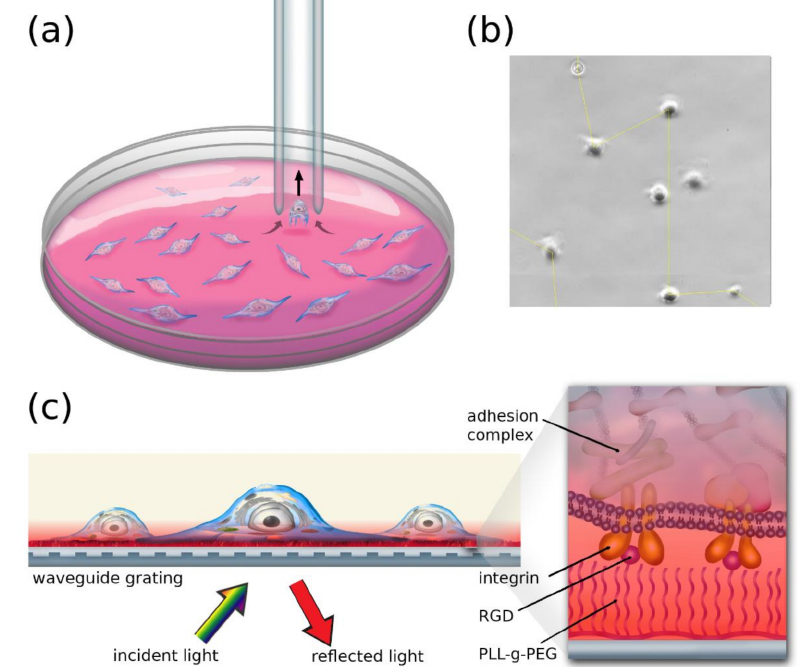
Figure 1. Illustration of the methods used to measure cell adhesion ( a ). The computer-controlled micropipette (CCMP) automatically visits each detected cell and probes them by applying a preset negative pressure. In the drawing, the targeted cell detaches from the surface and enters the micropipette. The ratio of cells picked up in a round is determined by scanning the area of interest with the optical microscope on which the CCMP is mounted. The size of the Petri dish and the cells are not to scale for better visibility ( b ). Section of a field of view in a Petri dish containing adhered HeLa cells. The yellow line shows the path of the micropipette that was automatically calculated by the CCMP control software. Note that the two cells that were too close to each other (closer than 70 µ m) were excluded from the measurement. ( c ) Schematic representation of the resonant waveguide-based measurement. The cells adhere to the sensor plate, which is illuminated from